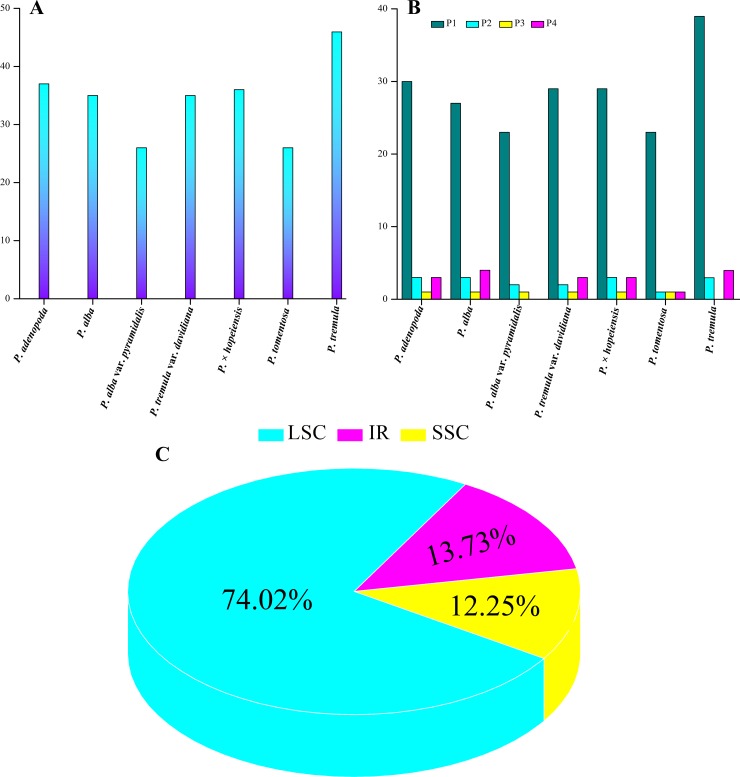
Comparison of SSRs among the seven cp genomes.(A) The number of SSRs detected in seven Populus cp genomes. (B) The number of SSR types detected in seven Populus cp genomes: P1, mononucleotide repeat; P2, dinucleotide repeat, P3, trinucleotide repeat and C, compound repeat (C) Frequencies of identified SSRs.